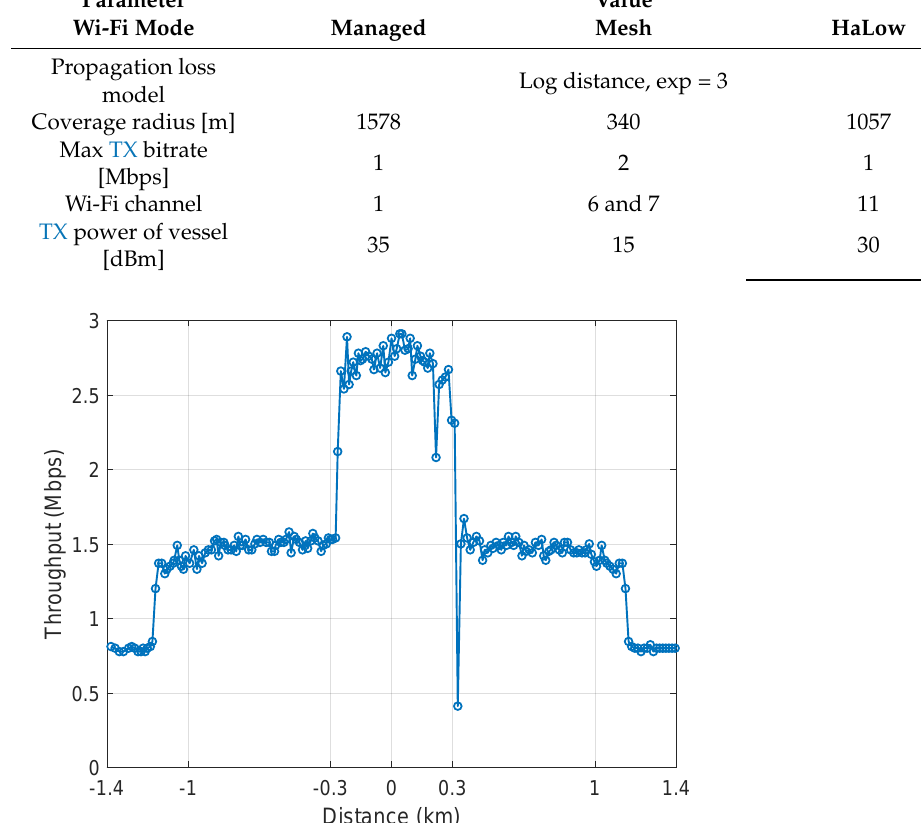
Figure 8. MPTCP throughput of mobile vessel STA2 using all available wireless links.